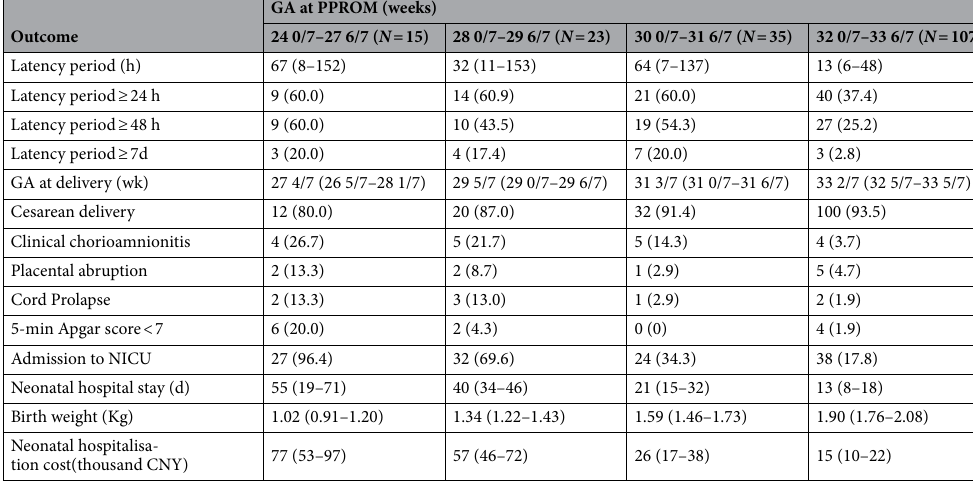
Table 2. Clinical outcomes by GA at membrane rupture for twin pregnancies. Data are median (Q1-Q3) or N (%). GA gestational age, NICU neonatal intensive care unit, CNY China Yuan.